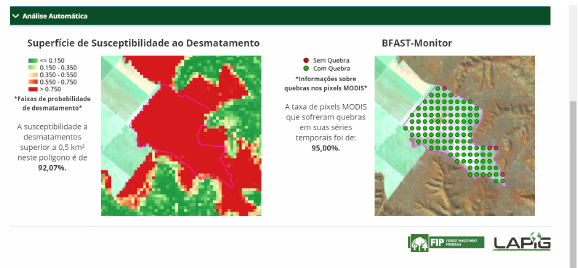
Figure 12. Deforestation Report presenting the results obtained during the automatic validation